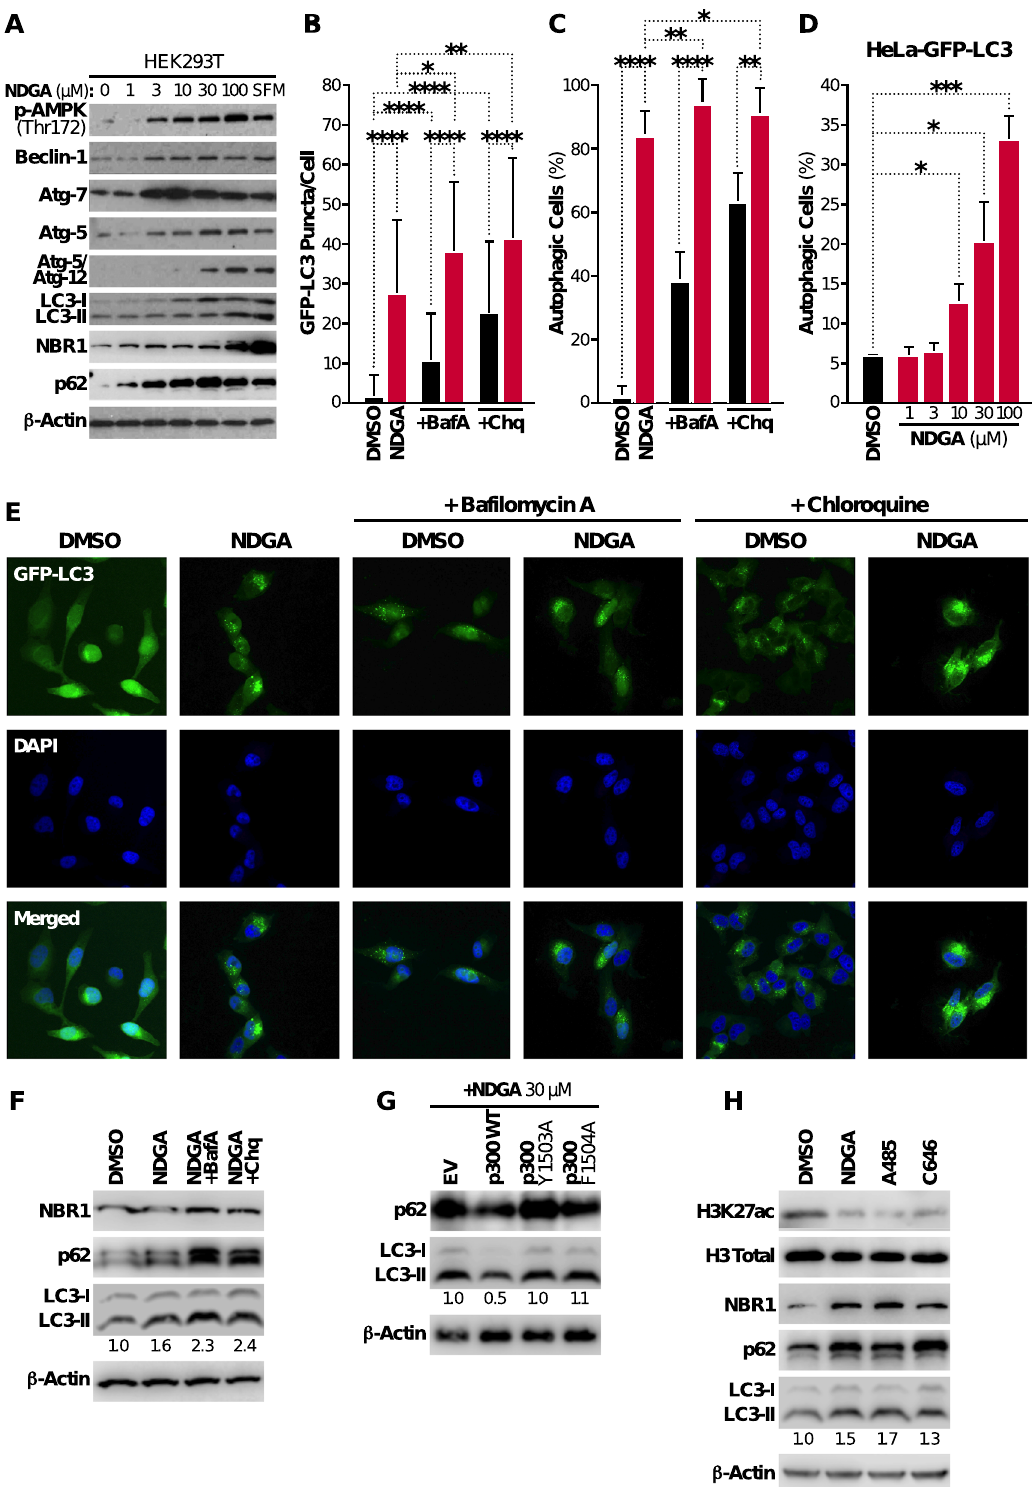
Supplementary Fig. 6), consistent with induction of autophagy. In addition, we observed upregulation of LC3-II, which is associated with autophagosome formation as well as upregulation of the autophagy cargo receptors NBR1 (Neighbor of BRCA1 gene 1) and p62 (SQSTM1, Sequestosome-1) upon treatment with NDGA (Fig. 4a, Supplementary Fig. 6). To con fi rm the induction of